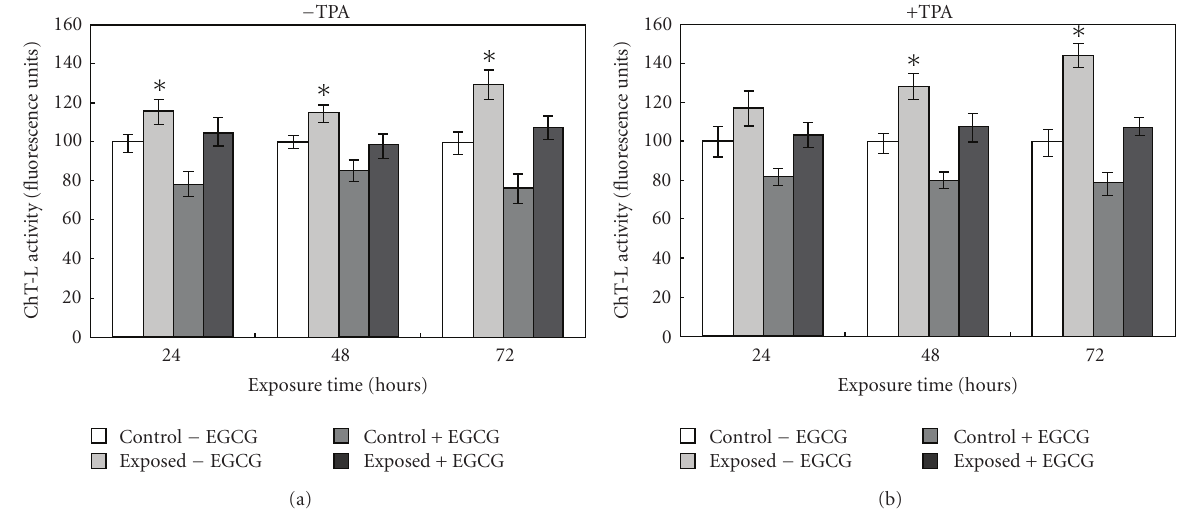
Figure 6: ChT-L activity measured in cell lysates upon exposure to ELF-EMFs and treatment with EGCG. Caco cells were treated or not with 150 μ M EGCG for 24, 48, and 72 hours; they were exposed to ELF-EMFs while the control dishes were placed under the same conditions in a solenoid with no field. After harvesting and lysing the cells the ChT-L (suc-Leu-Leu-Val-Tyr-AMC) activity was executed in the cell extracts. Data are expressed as fluorescence arbitrary units subtracted of the values of control assays in the presence of specific inhibitors. Data are mean ± SE of six separate experiments. Asterisks represent statistically significant di ff erences from the respective control, not exposed, cultures: P < .